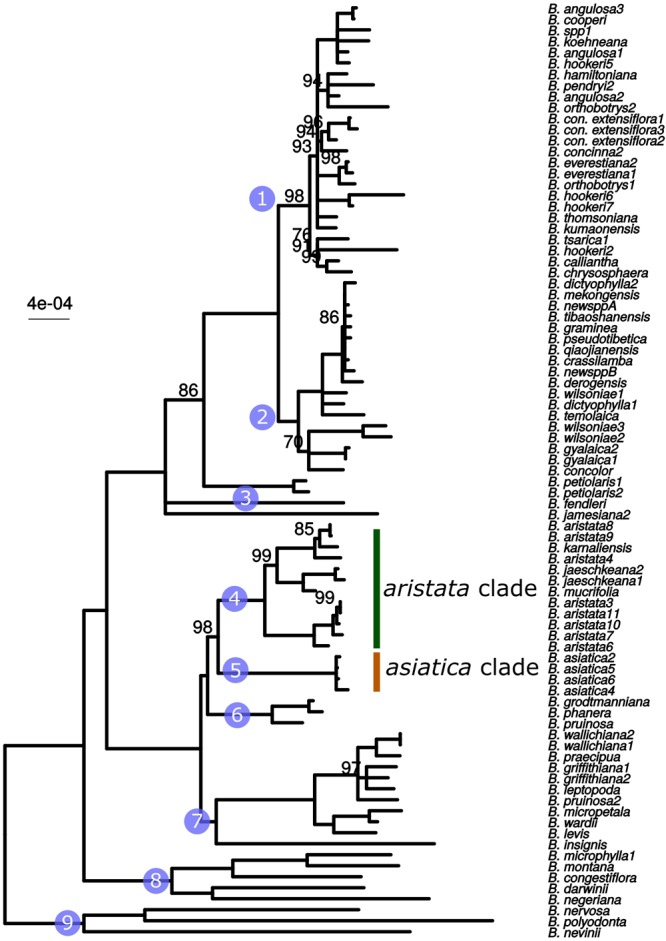
ML phylogeny based on whole plastid sequences. Note that B. aristata, in the aristata clade, is a polyphyletic species, but that B. asiatica samples in the asiatica group comprise a monophyletic group. Numbers above branches are bootstrap values between 51 and 99. Branches with support <50 were collapsed to polytomies, bootstrap values of 100 are not shown.